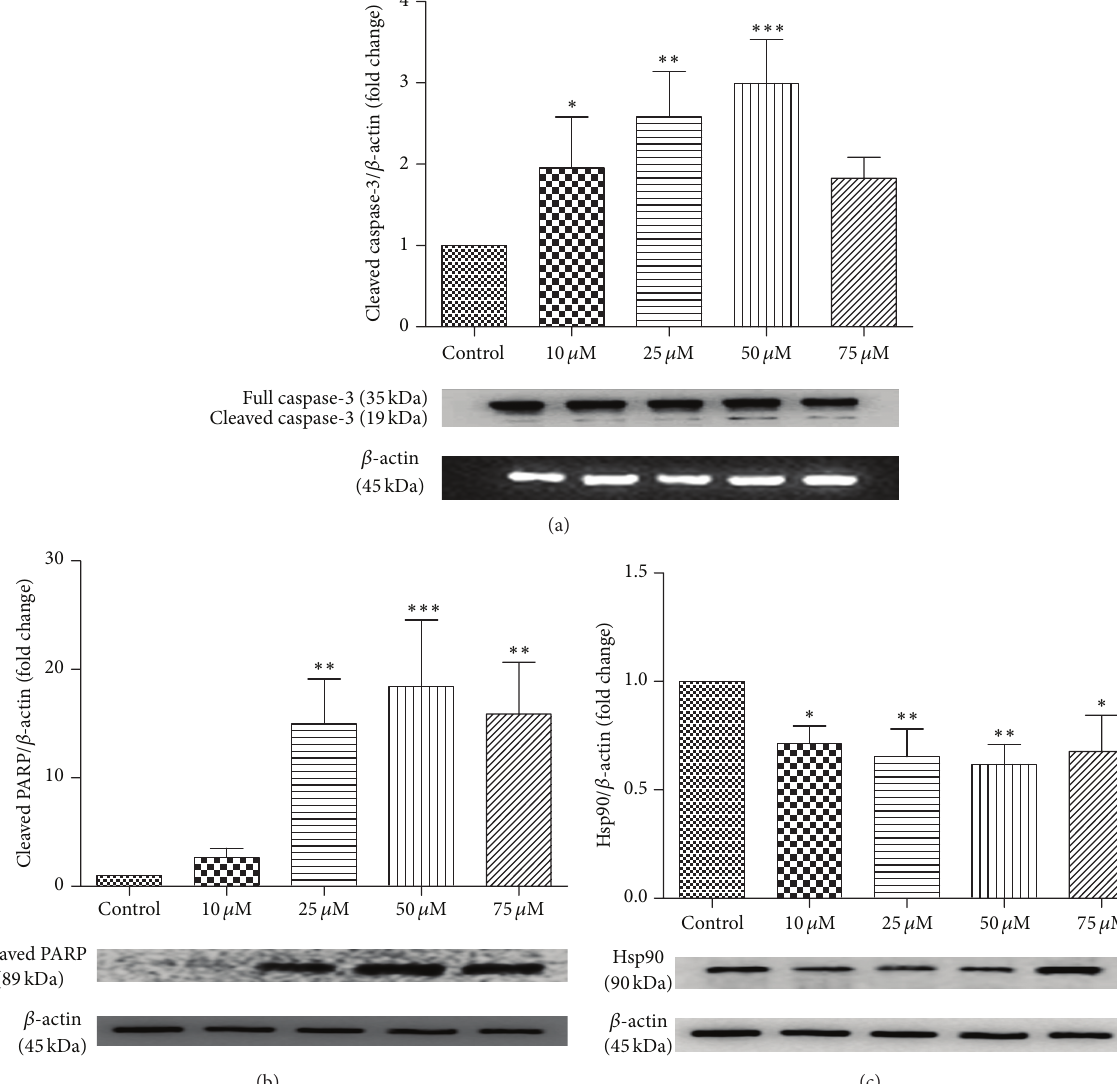
Figure 5: Western blot analysis of caspase-3 cleavage (a), PARP cleavage (b), and Hsp90 (c) protein expression levels after quercetin treatment of B-CPAP cells. Band intensity was analyzed by densitometry. Fold change of protein expression levels was calculated after bands were normalized to 𝛽 -Actin. Differences between means and significance of the treatments were analyzed using ANOVA and Bonferroni posttest. Bar graphs represent mean ± SD, 𝑛 = 3 . ∗ 𝑝 < 0.05 versus control, ∗∗ 𝑝 < 0.01 versus control, and ∗∗∗ 𝑝 < 0.001 versus control.